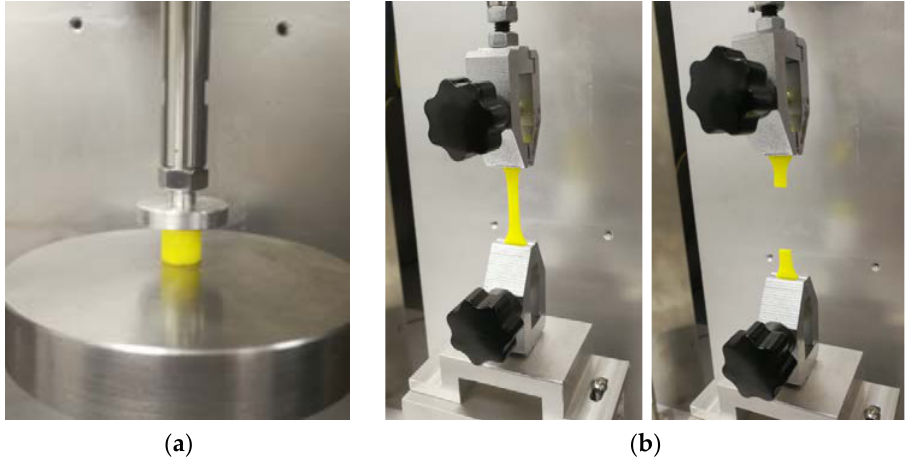
Figure 4. Process of material test: ( a ) Compression test; ( b ) Fracture of sample after tensile test.